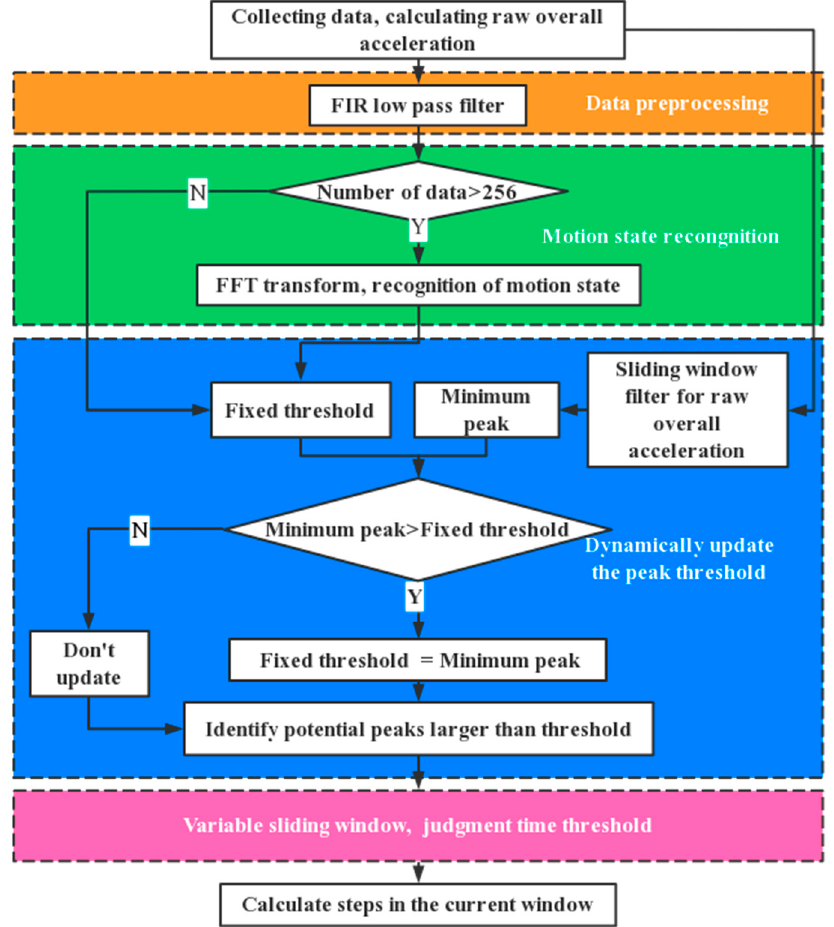
Figure 6. Flow chart of the unconstrained step detection algorithm.